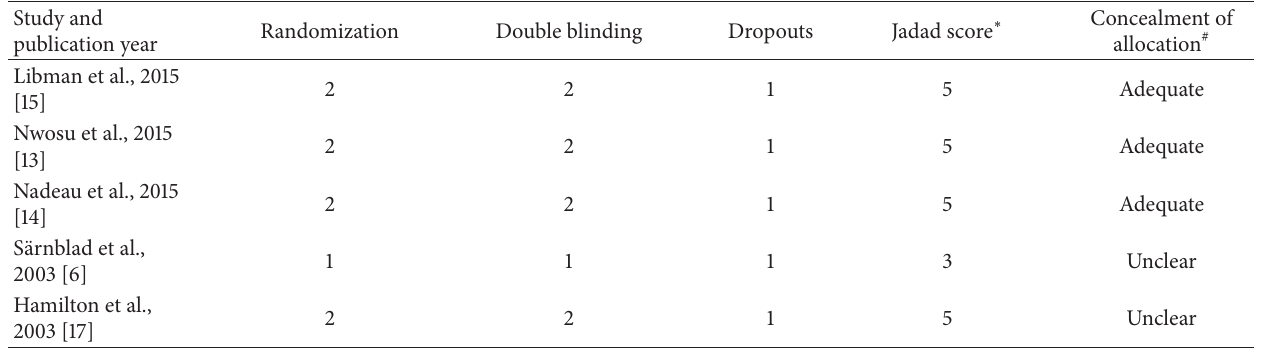
Table 2: Quality assessment of individual studies.